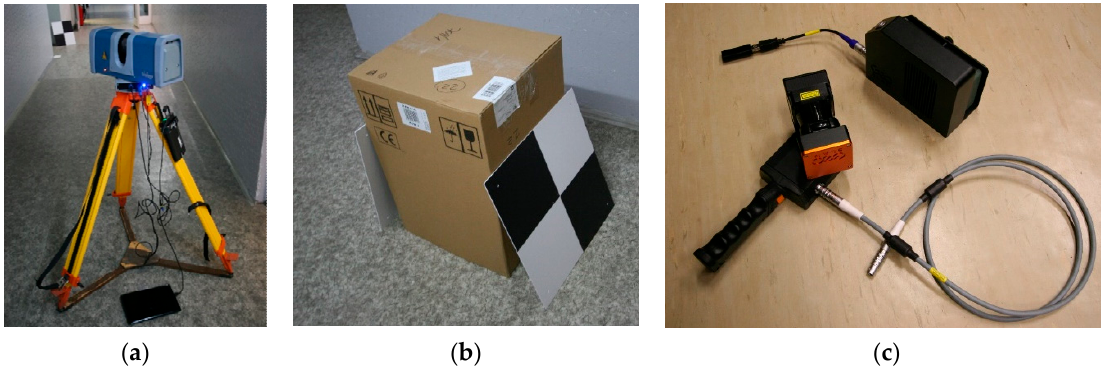
Figure 6. ( a ) Precise laser scanner Surphaser 25 HSX, ( b ) used targets for point clouds alignment, and ( c ) ZEB-REVO personal mobile laser scanner.